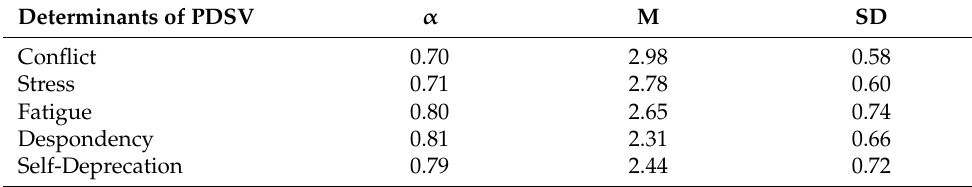
Table 4. Results in the determinants of burnout syndrome PDSV methodology: α , M, SD. Determinants of PDSV α